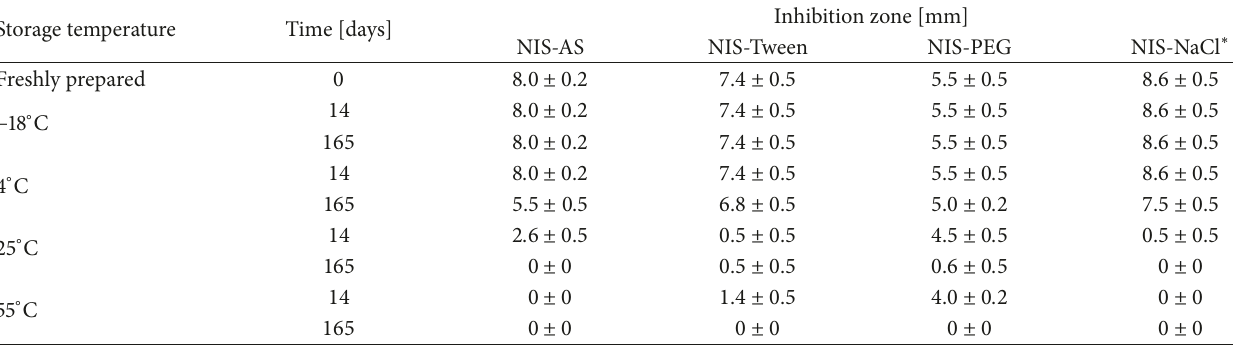
Table 3: Determination of nisin antibacterial activity on the growth of S. aureus by agar-well diffusion method. Data points are average values of three independent